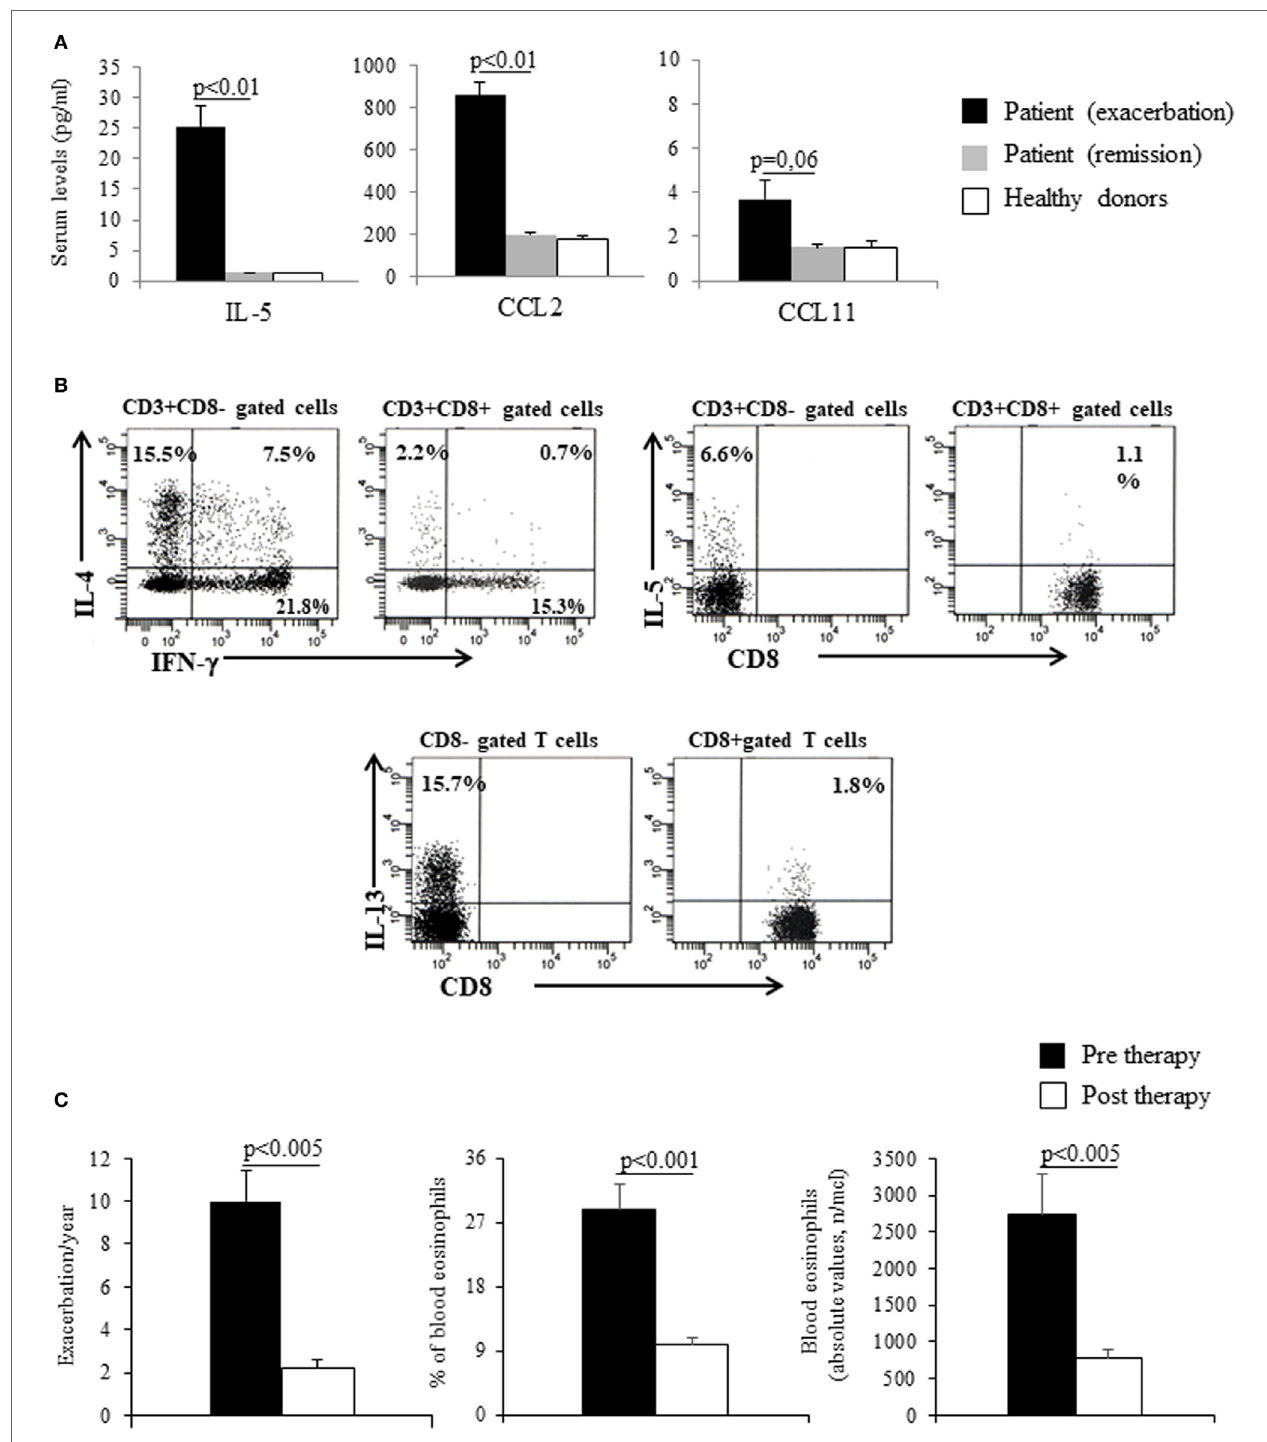
FIGURe 1 | (a) Cytokines and chemokines serum levels during acute exacerbations and clinical remissions in the patient. Healthy donors’ values are reported as control. Mean values ± SEM are reported. (B) Cytofluorimetric analysis of cytokines production of peripheral blood T lymphocytes (CD3 gated) before treatment (peripheral blood mononuclear cells were polyclonal stimulated for 6 h in the presence of phorbol myristate acetate plus ionomycin, in the last 4 h brefeldin A was added to inhibit cytokines exocytosis. After stimulation, cells were fixed in formaldehyde, and cell membranes were permeabilized with saponin to permit the staining of intracellular cytokines with the appropriate fluorochrome-conjugated monoclonal antibodies. Samples were evaluated by BLSRDII flow-cytometer (BD- Biosciences, San Jose, CA, USA). At least 104 elements were acquired for each sample and analyzed by FacsDiva BD software. (C) Exacerbation/year and blood eosinophils (absolute value and percentage) before and after the treatment. Mean values ± SEM are reported.